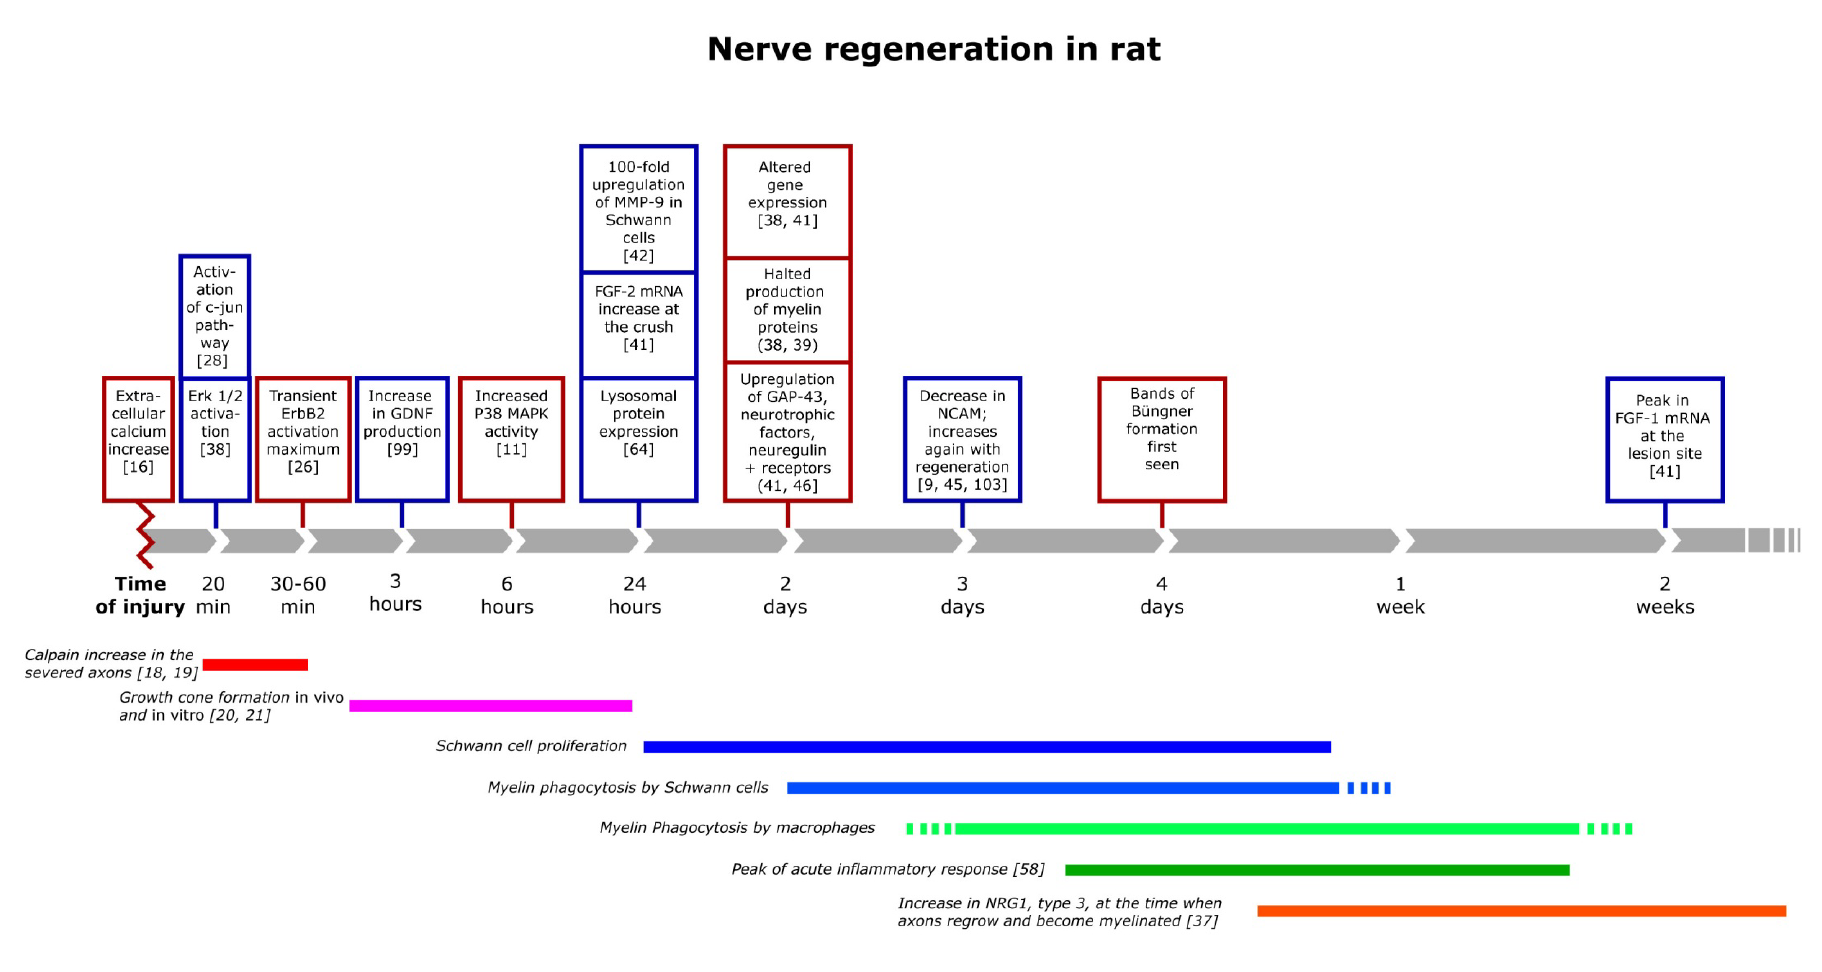
Figure 1. Timeline of major events important for nerve repair after injury, depicting many of the events known (that could be found in the literature) to occur after an injury. Most of these are likely important for the repair